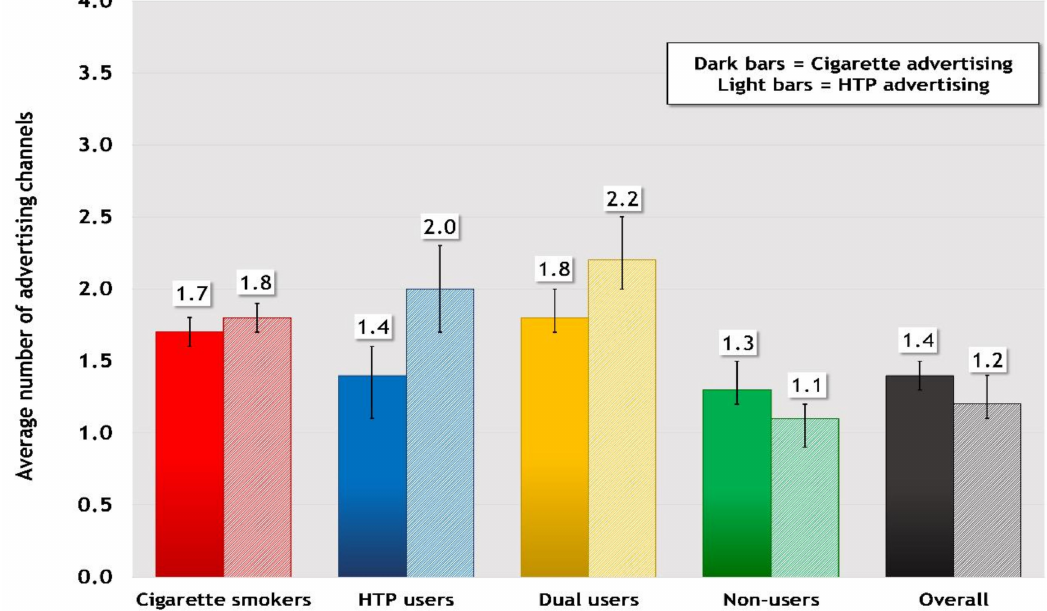
Figure 1. Average Number of Channels through which Cigarette and Heated Tobacco Product (HTP) Advertising was Noticed in the Last 6 Months † Respondents were asked whether they noticed cigarette and HTP advertising in 8 channels common to both forms of tobacco: TV, radio, newspapers or magazines, posters or billboards, in stores (for cigarette advertising: on store windows or inside stores where tobacco is sold; for HTP advertising: on store windows or inside stores where tobacco is sold + on store windows or inside stores where HTPs are sold), email, social media, and bars or pubs. Results are shown for the average number of channels for which respondents reported noticing advertising for each type of tobacco in the last 6 months. Overall refers to the entire sample of